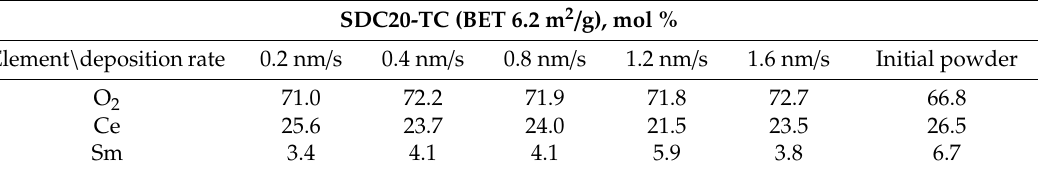
(b) Figure 4. XRD patterns of SDC20 thin films deposited on SiO 2 substrates at (a) a 0.4 nm/s deposition rate and different substrate temperatures; (b) temperature of the substrate, 50 °C, at different deposition rates. The crystallite size depended on the temperature of the substrate and the deposition rate (Figure 5) and it was higher using substrates of higher temperature during the deposition (9.7–80.6 nm). The deposition rate had little effect on the crystallite size at low deposition temperatures (lower than 300 °C ). However, at high temperatures (450 °C and 600 °C ) and low deposition rates (lower than 0.8 nm/s), fluctuations of crystallite size appeared.